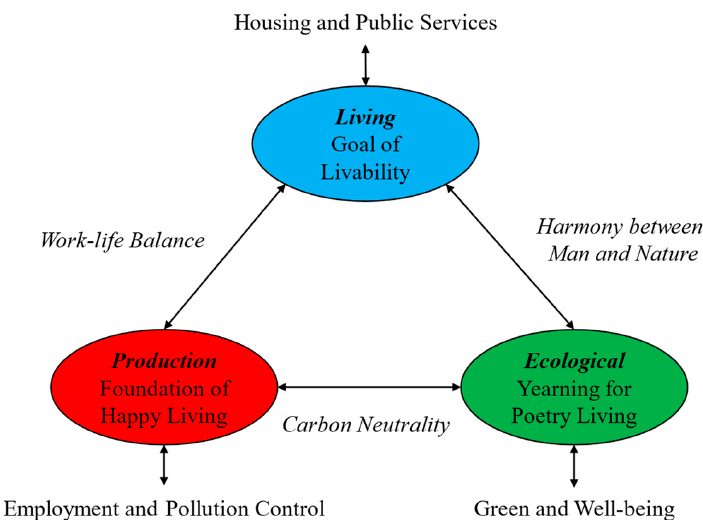
Figure 2. The interactive relationship of production–living–ecological spaces.